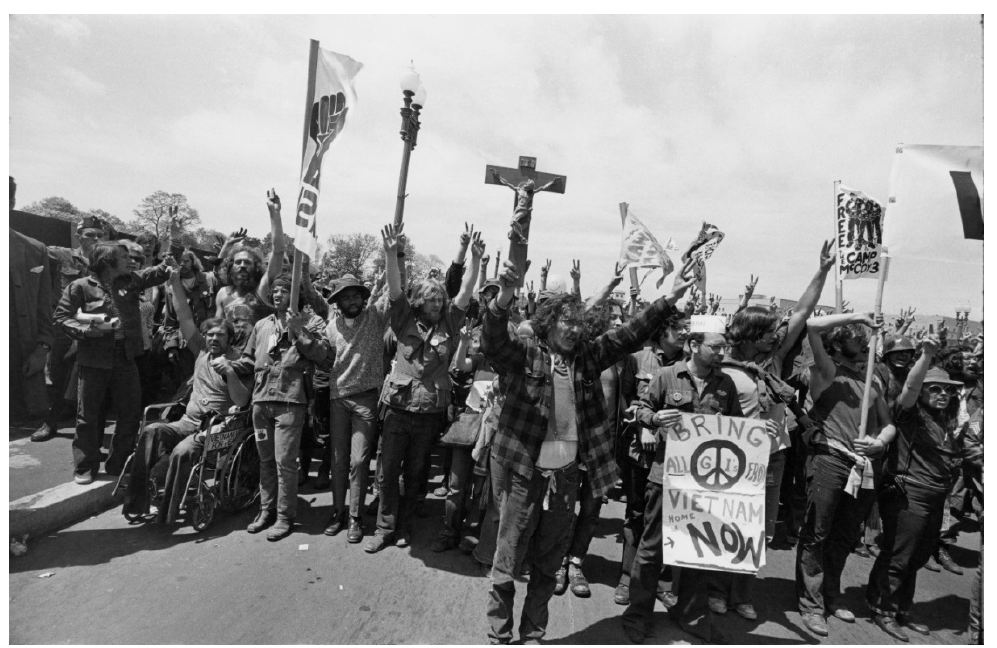
Figure 2. Garry Winogrand, Peace Demonstration, Washington, DC , 1971, Gelatin silver print, 26.4 × 40.4 cm, Museum of Modern Art, New York, USA. © The Estate of Garry Winogrand, courtesy Fraenkel Gallery, San